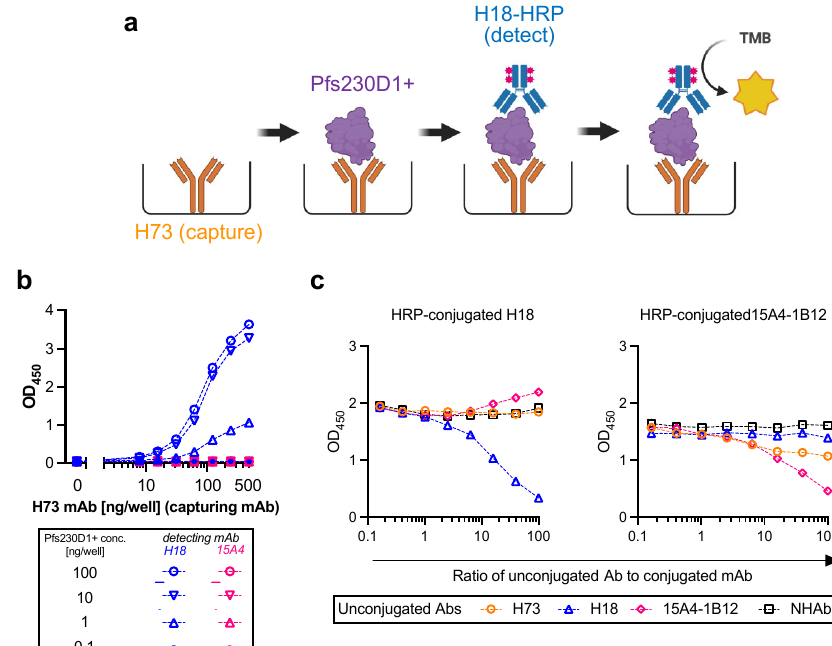
Figure 1. Development of Antigen Integrity Assay (AIA). ( a ) Basic principle of AIA. ( b ) An ELISA plate was coated with H73 mAb at different concentrations (0 to 500 ng/well, x -axis), then different concentrations of reference Pfs230D1+ protein (0.1 to 100 ng/well, different shapes) were applied. After wash, a fixed concentration (27.7 ng/well) of either HRP-conjugated H18 (blue) or HRP-conjugated 15A4-1B12 (red, 15A4) mAbs were added to detect the Pfs230D1+ protein. ( c ) Competition ELISA using ELISA plates coated with reference Pfs230D1+ protein. Mixtures of HRP-conjugated H18 (left panel) or HRP-conjugated 15A4-1B12 (right panel) mAbs with unconjugated H73, H18, 15A4-1B12 or normal human antibody (NHAb, as a negative control) were generated at indicated ratio ( x -axis), and then applied to ELISA plates coated with reference Pfs230D1+ protein (100 ng/well). After 2 h of incubation, the plates were washed, then TMB substrate was added. The OD 450 signals from HRP-conjugated mAbs are shown in y -axis.